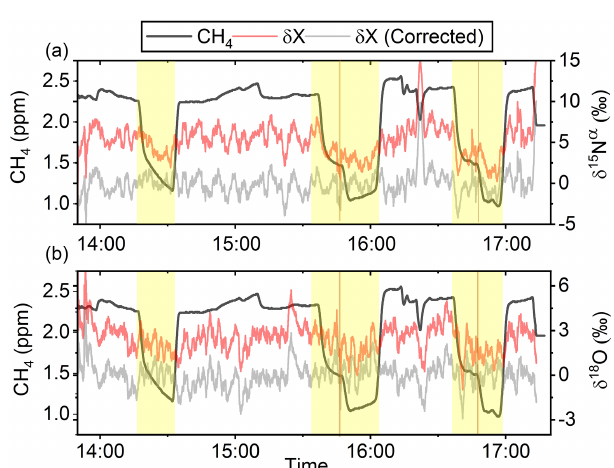
Figure 5. (a) Measurements of δ 15 N α during exp. L (‰). Red high- lights a 100s average measured value corrected for O 2 , CO and CO 2 effects, while the grey line indicates a 100s average value cor- rected for all interference including CH 4 . The black line shows the CH 4 level (ppm). (b) Measurements of δ 18 O from exp. L (‰). Red highlights a 100s average measured value corrected for O 2 , CO and CO 2 effects, while the grey line indicates a 100s average value cor- rected for all interference including CH 4 . The black line shows the CH 4 level